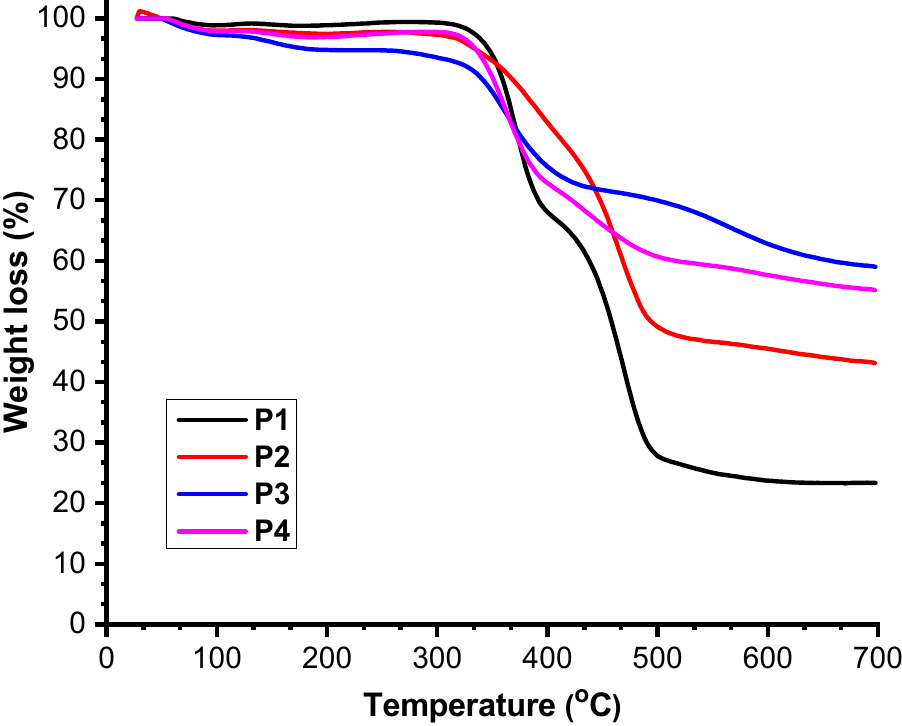
Figure 3. TGA curves of naphthyl(di)imide-based polymers P1 – P4 .